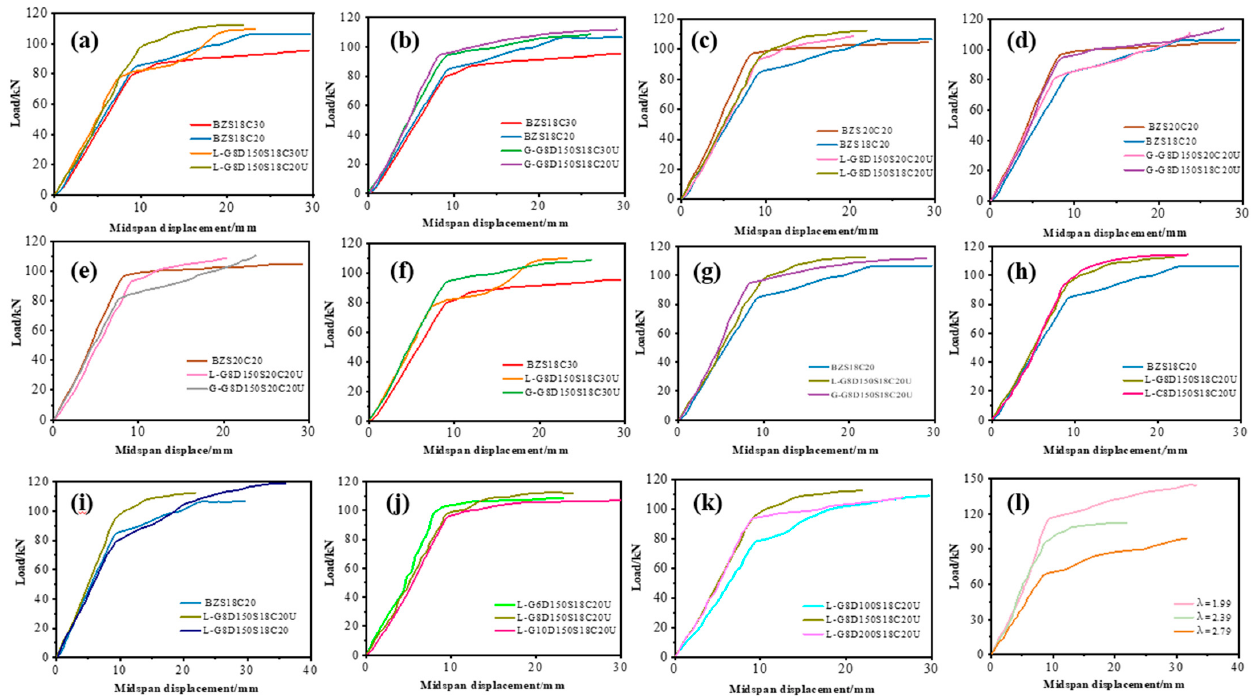
Figure 7. Load versus displacement curves. ( a ) Different concrete strength grade thread GFRP reinforcement test pieces; ( b ) different concrete strength grade light round GFRP reinforcement test pieces; ( c ) different longitudinal reinforcement ratio GFRP reinforcement test pieces; ( d ) different longitudinal reinforcement ratio light round CFRP reinforcement test pieces; ( e ) different surface features GFRP S20C20; ( f ) different surface features GFRP S18C30; ( g ) different surface features GFRP S18C20; ( h ) different types of FRP reinforcement test pieces; ( i ) different reinforcement methods GFRP reinforcement test pieces; ( j ) GFRP reinforcement test pieces with different diameter threads; ( k ) GFRP reinforcement test pieces with different spacing; ( l ) different shear span ratio GFRP reinforcement test pieces.